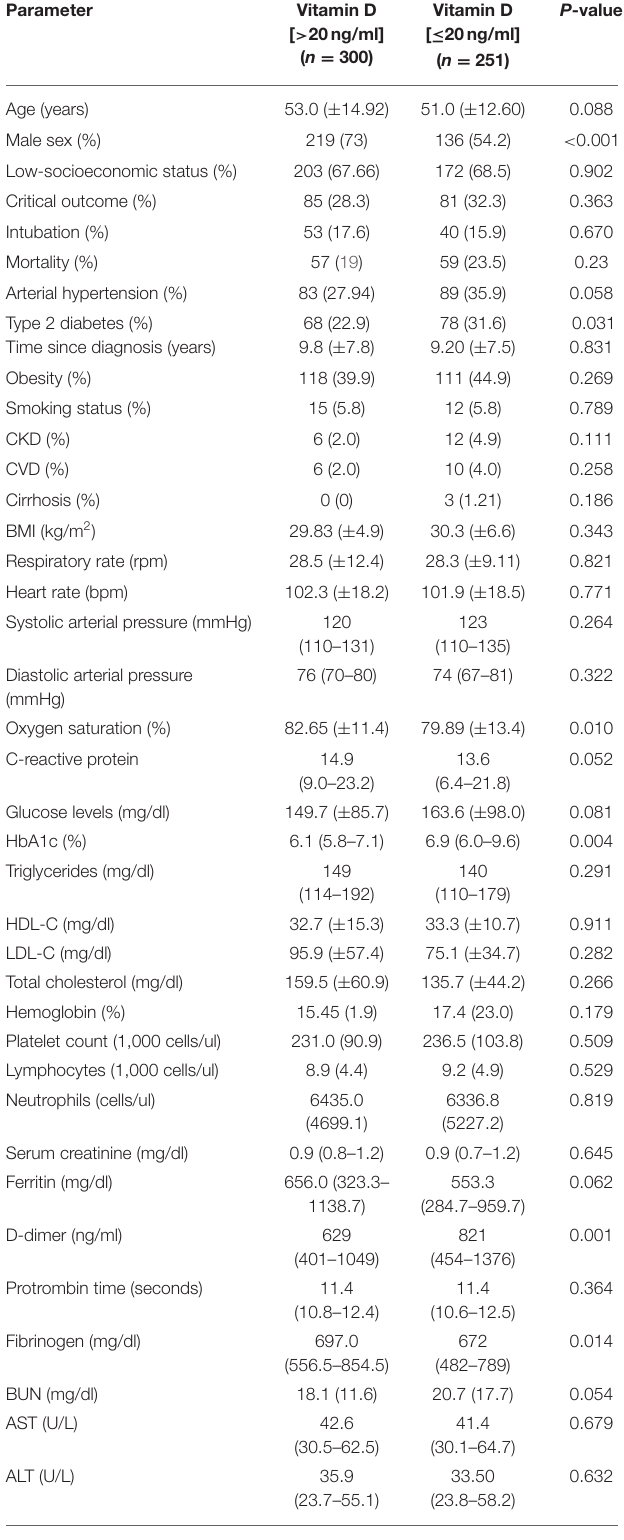
TABLE 1 | Clinical characteristics, imaging findings and severity scores in patients with COVID-19, comparing cases with and without low vitamin D levels.